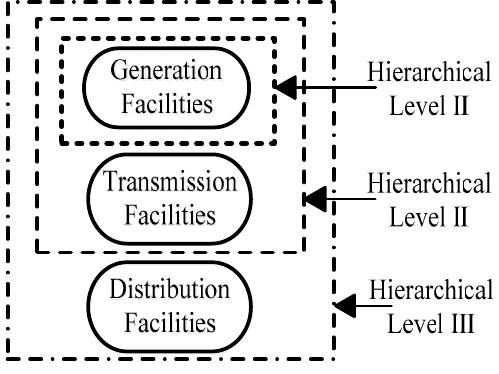
Figure 2. Hierarchical levels of power systems.